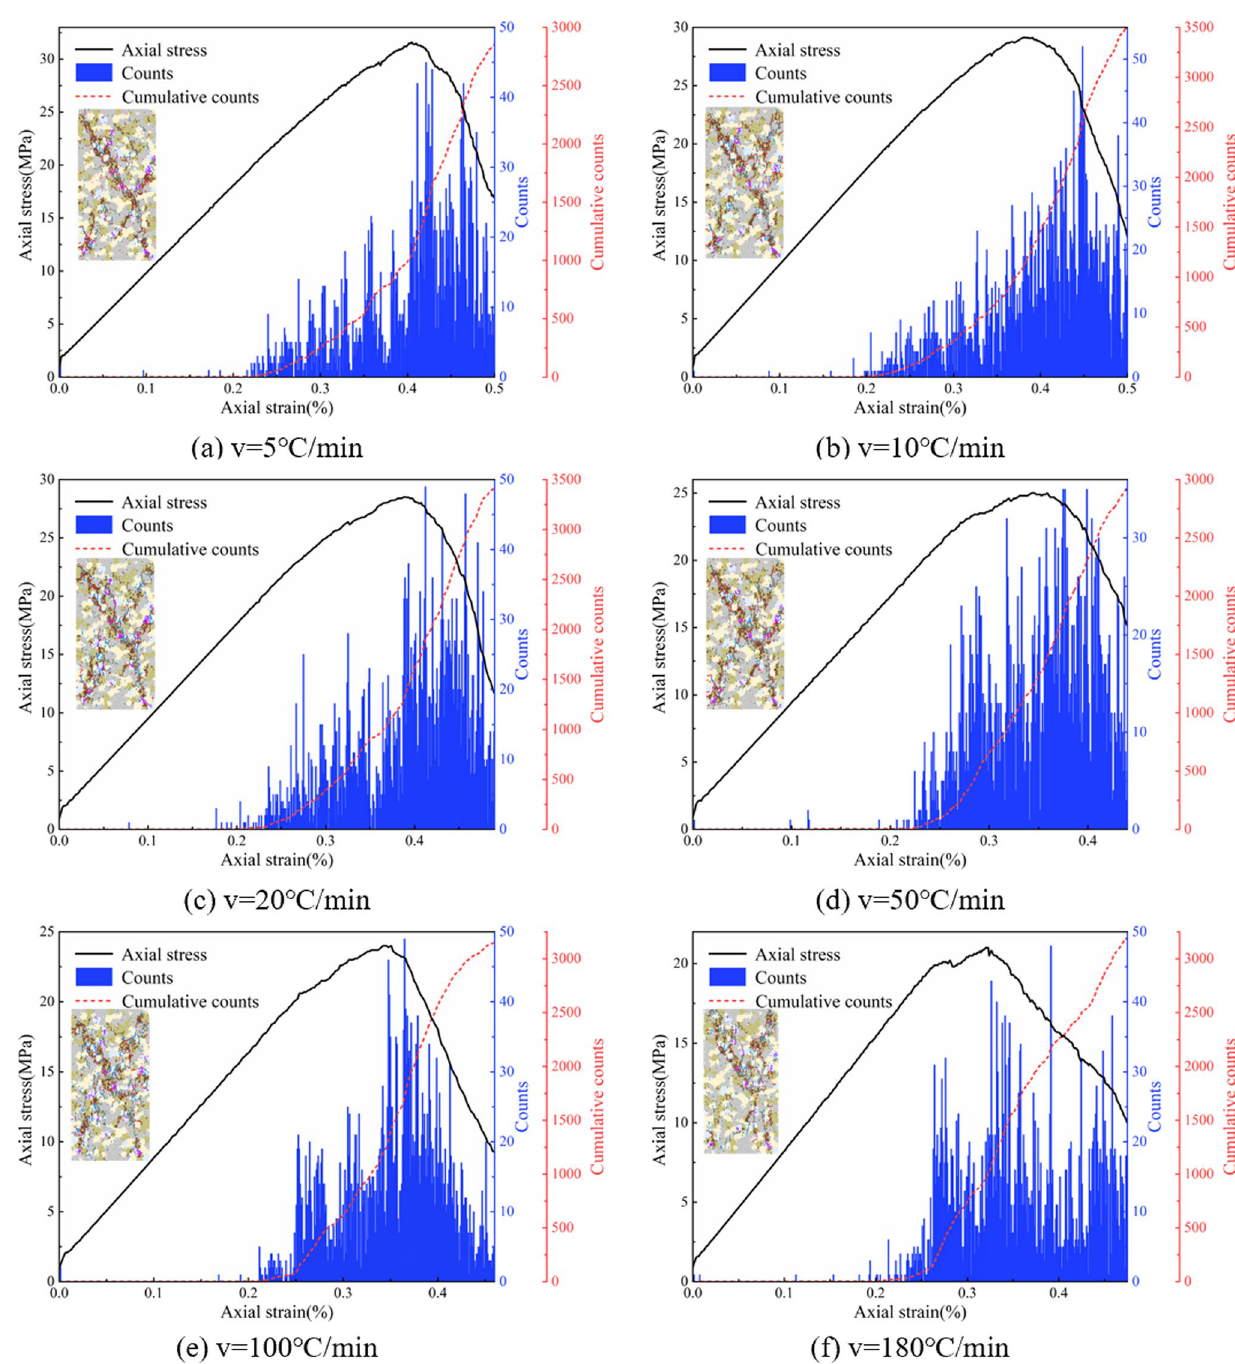
Fig. 7 Evolutions of the axial stress, AE counts and cumulative AE counts of sandstone as axial